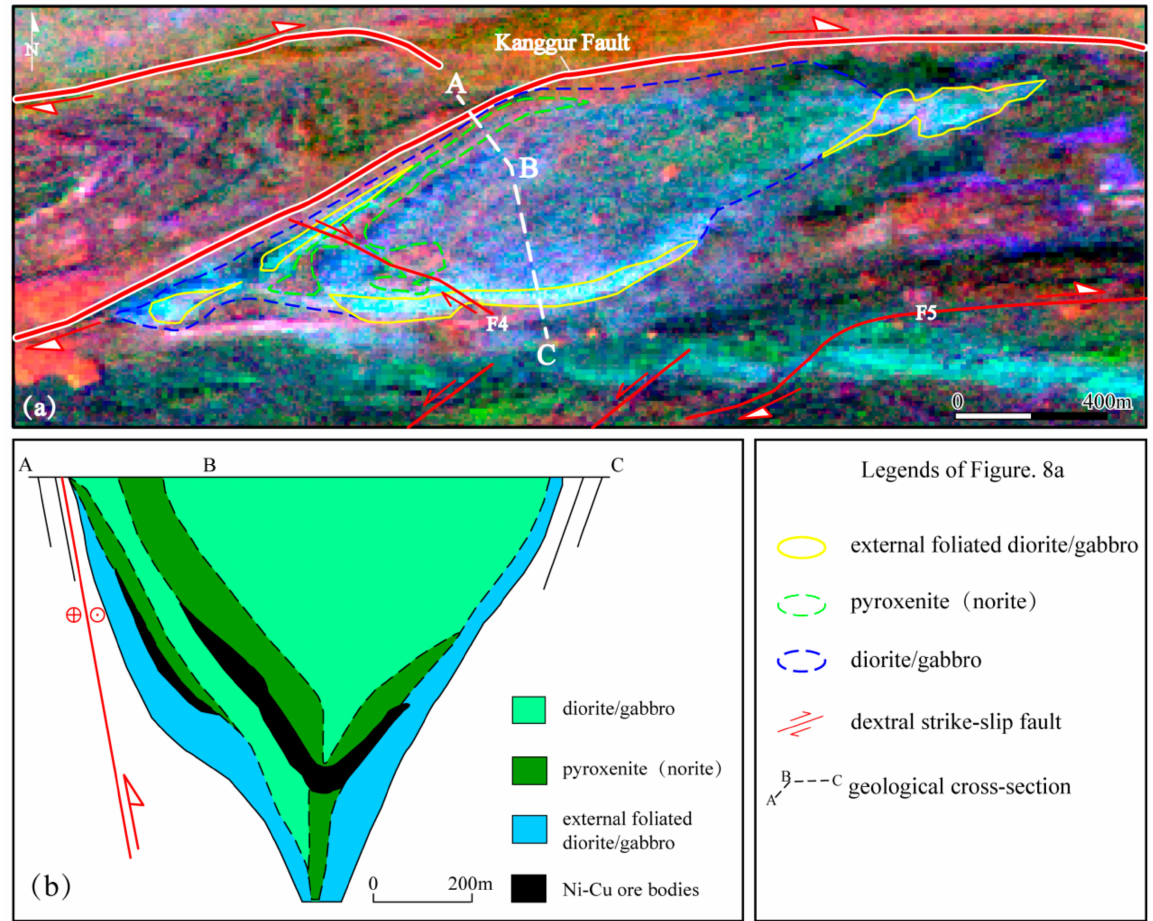
Figure 10. Enlarged ASTER false color composite image of b2/b1 (R), b6/b7 (G) and b4/b8 (B) of HSD intrusion ( a ), geological cross-section ( b )